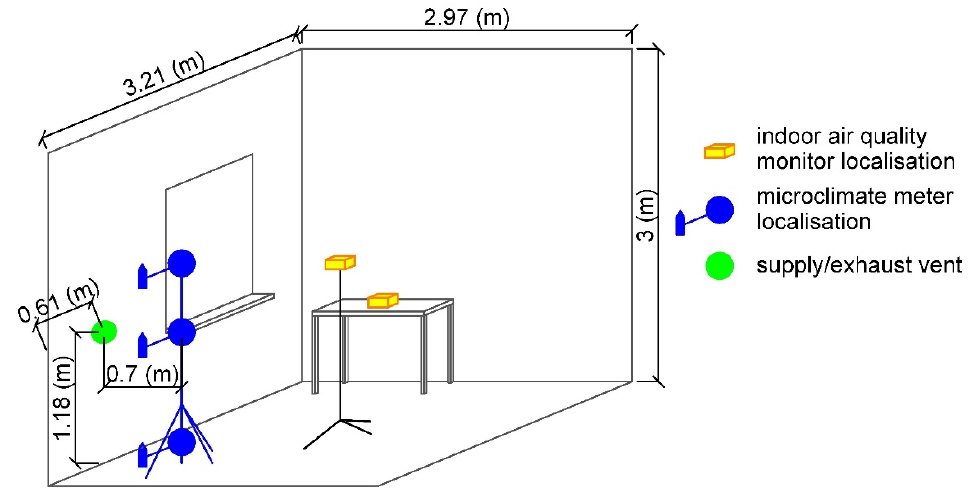
Figure 1. Layout of meters and the decentralised façade unit in the analysed room.